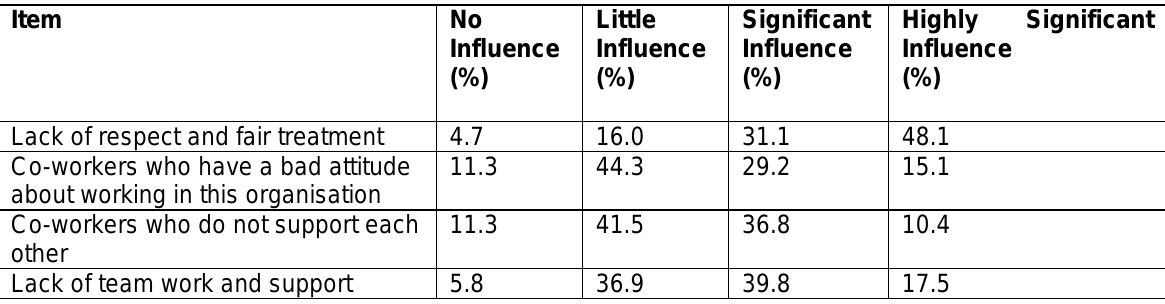
Table 8: Perceived influence of Team Dynamics on the respondents’ consideration to leave